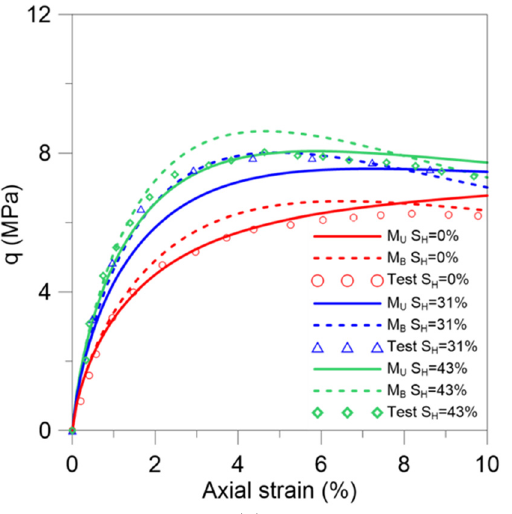
Figure 6. Modeling the tests reported in Miyazaki et al. [82] at 𝜎 3 = 2 MPa. ( a ) Deviatoric stress versus axial strains; ( b ) volumetric strains versus axial strains.